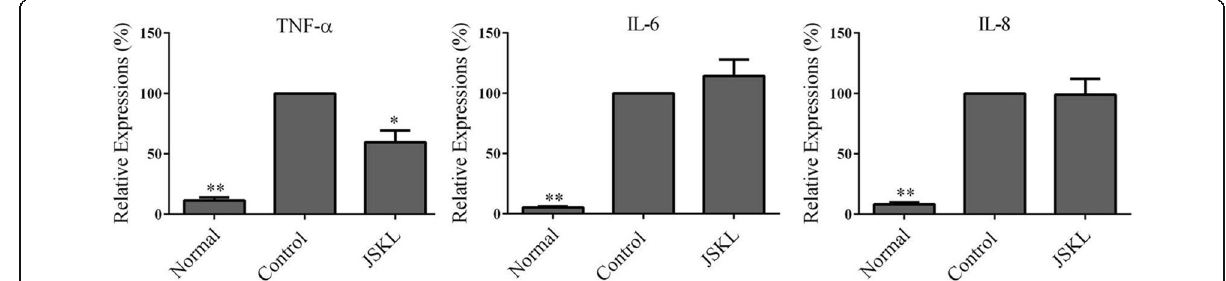
Fig. 2 Effect of JSKL on the expression of pro-inflammatory cytokines in MH7A cells stimulated by LPS. *p < 0.05, **p < 0.01 vs control group